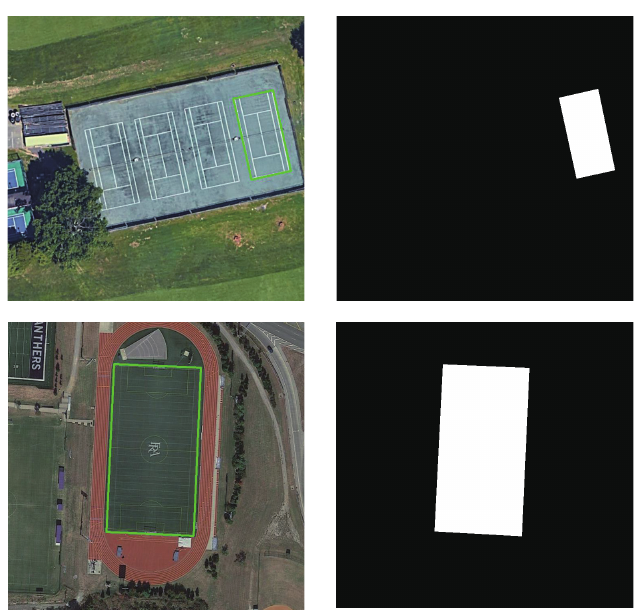
Figure 3. Ground Truth. ( Left ) Image samples with green polygon. ( Right ) Binary instance labels.